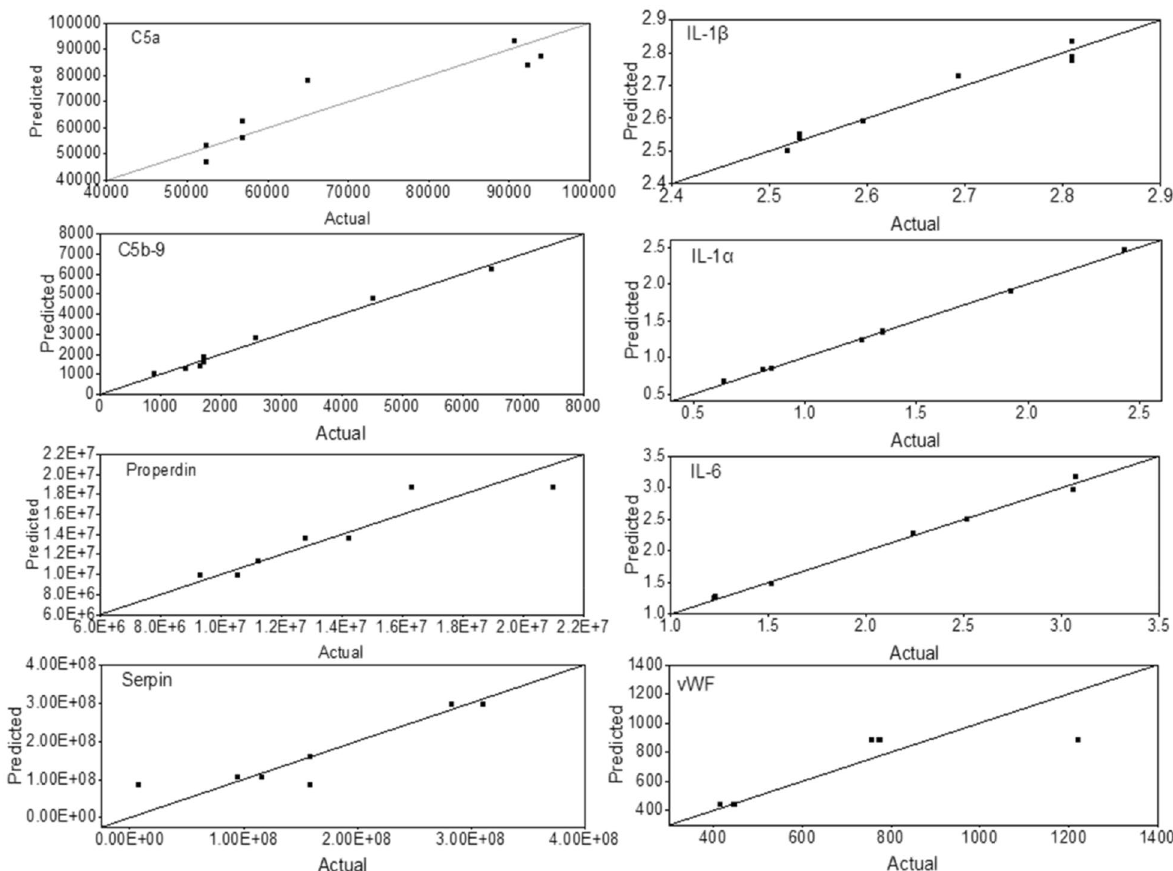
Figure 3. Predicted vs. actual values of the concentration (pg/mL) of C5a, IL-1β, C5b-9, IL-1α, properdin, IL-6, serpin, and vWF. Predicted values were obtained using Eqs. (33–40) (affinity-based model) without correction factors (Origin(Pro), Version 2020b, https:// www. origi nlab. com/ index. aspx? go= Produ cts/